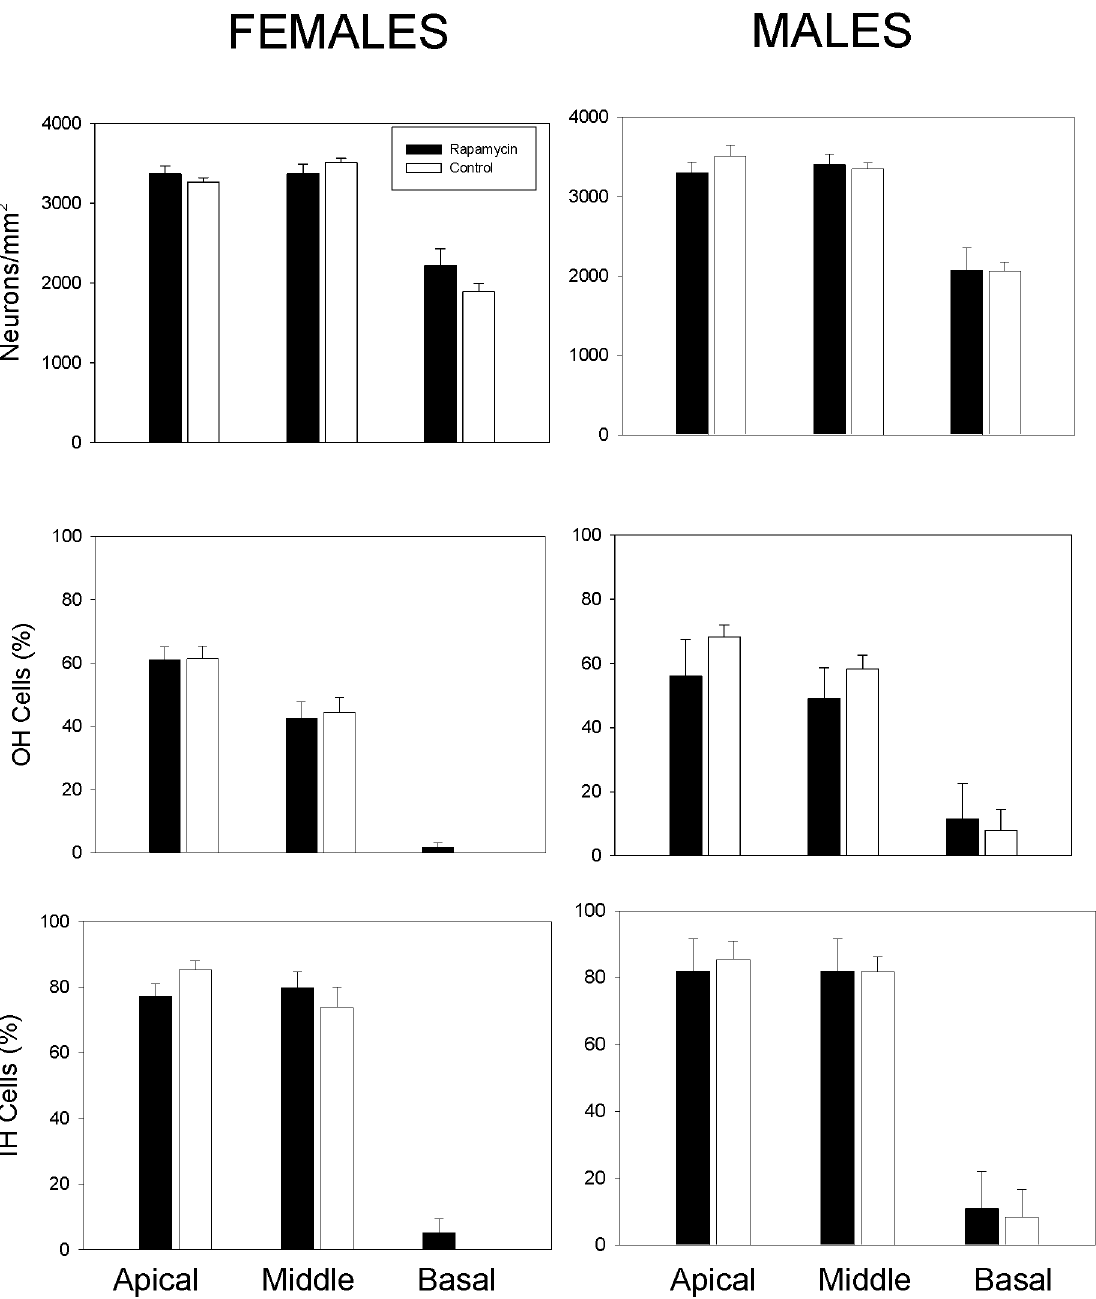
Fig 6. Age-related changes in inner ear histology was not altered by rapamycin treatment. A, B: The number of cochlear neurons in male and female mice were not statistically different between control and rapamycin-fed animals. C,D: The number of outer hair cells in male and female mice were not statistically different between control and rapamycin-fed animals. E,F: The number of inner hair cells in male and female mice were not statistically different between control and rapamycin-fed